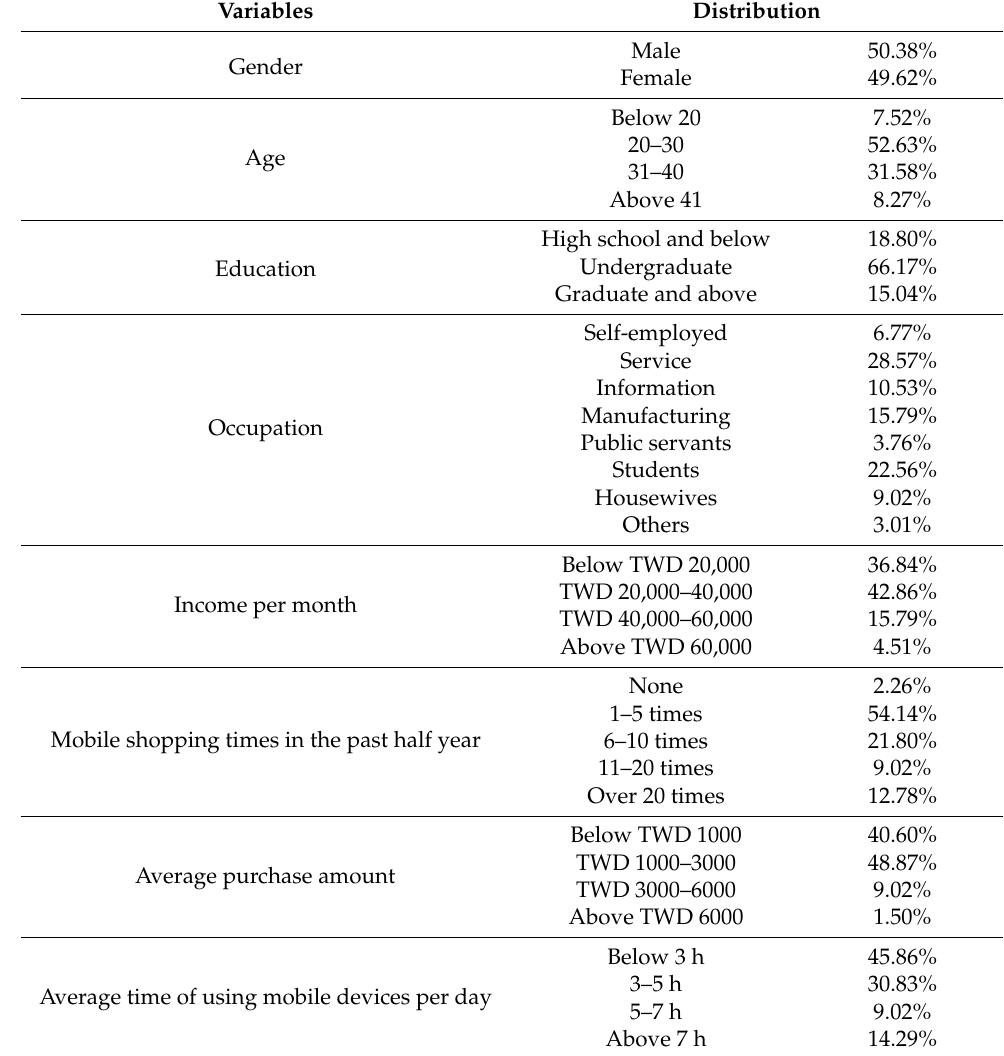
Table 3. Descriptive statistics of the selected